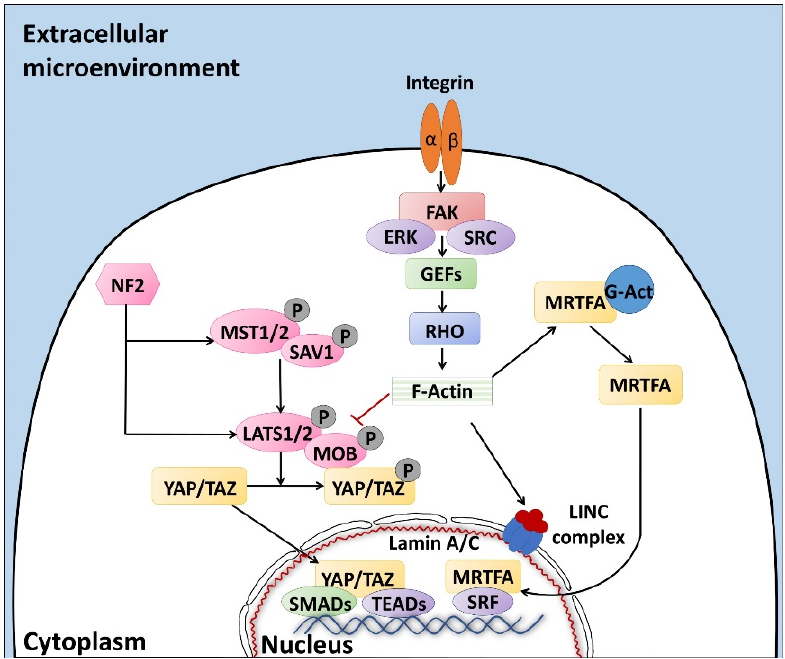
Figure 1. The sensors (integrins) and effectors (Rho and Hippo pathways) driving mechano-transduction processes, regulating YAP/TAZ localization and the subsequent cell behavior. Signaling pathways are described in detail in the text. Black arrow: activation, red T bar: inhibition of phosphorylation and molecule activation.